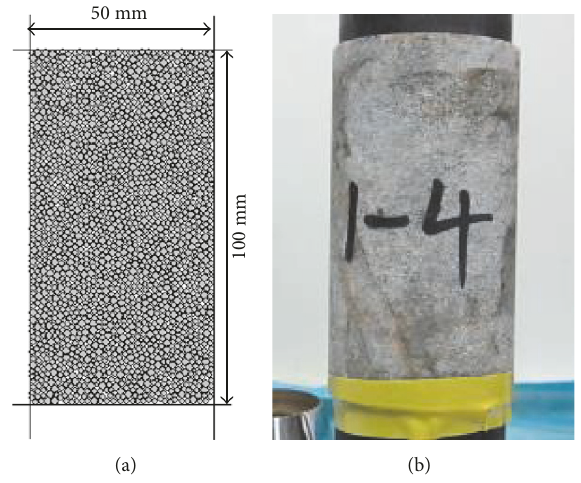
Figure 1: PFC model (a) and granite specimen (b).